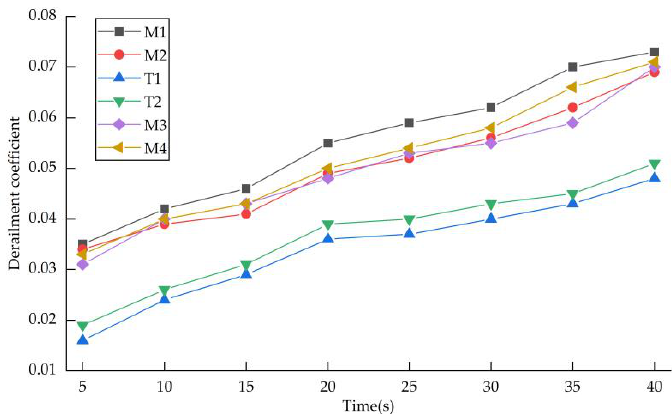
Figure 6. Derailment coefficient.